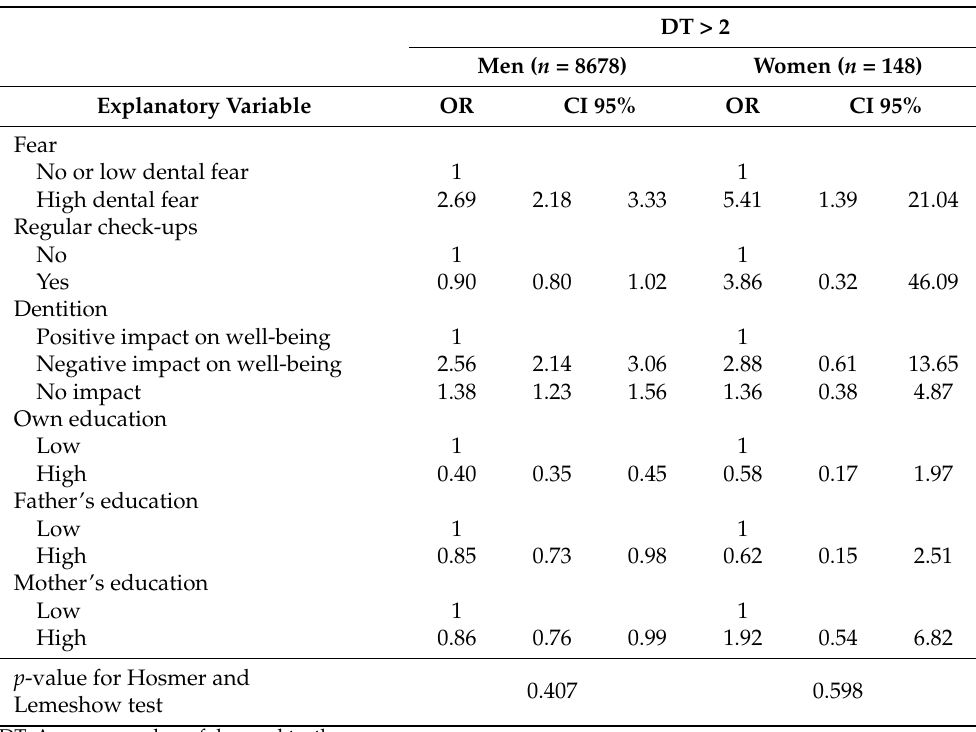
Table 4. A binary logistic regression model on the association of dental treatment need (DT > 2) and explanatory